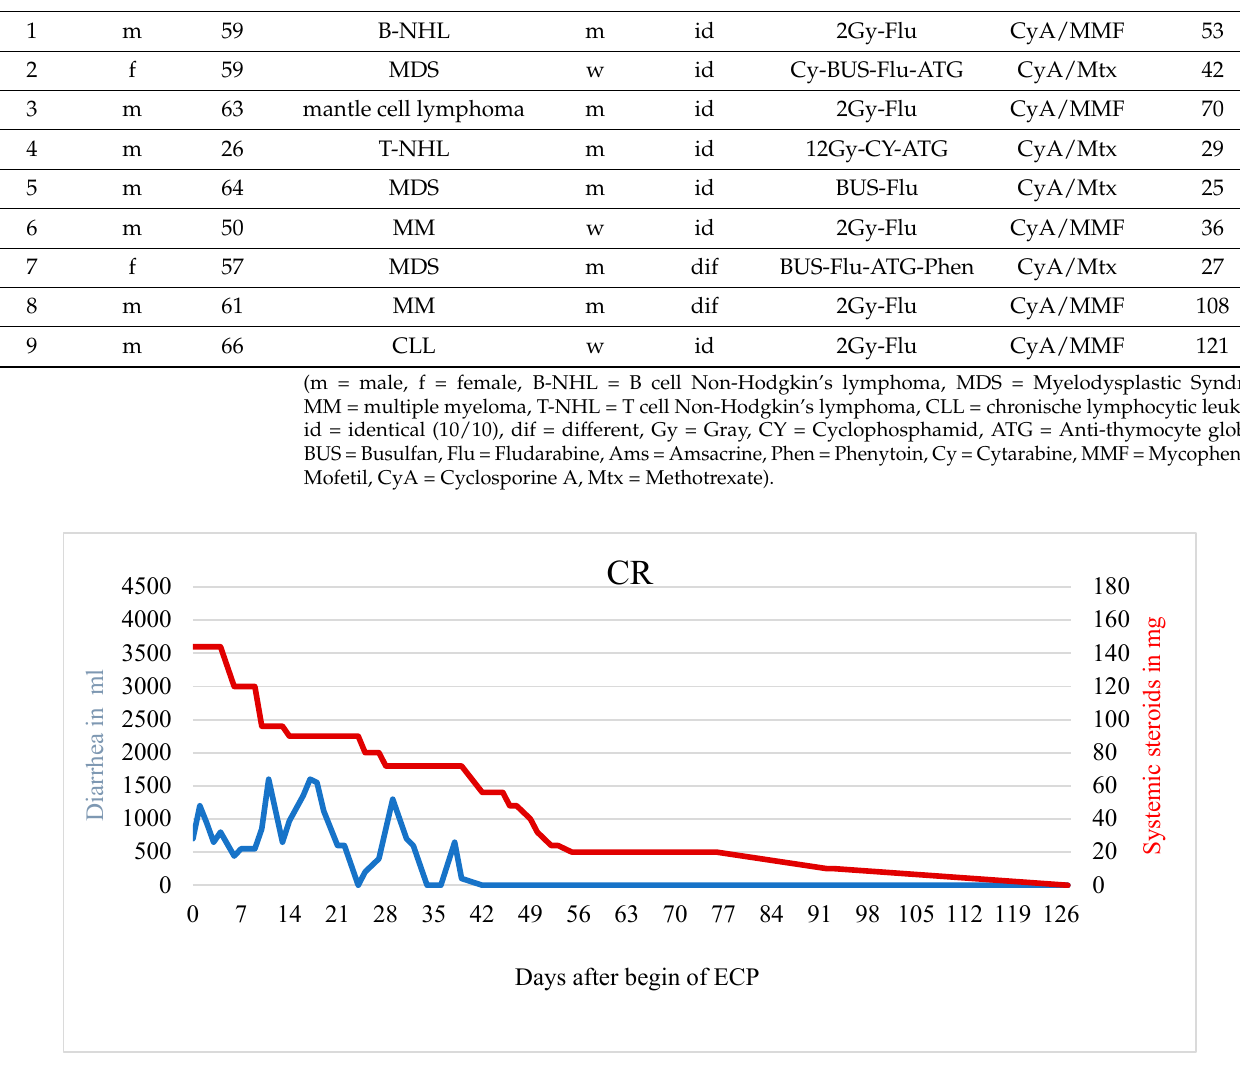
Figure 1. Patient with CR and significantly less diarrhea and usage of systemic steroids. The patient reported a decrease in abdominal pain during